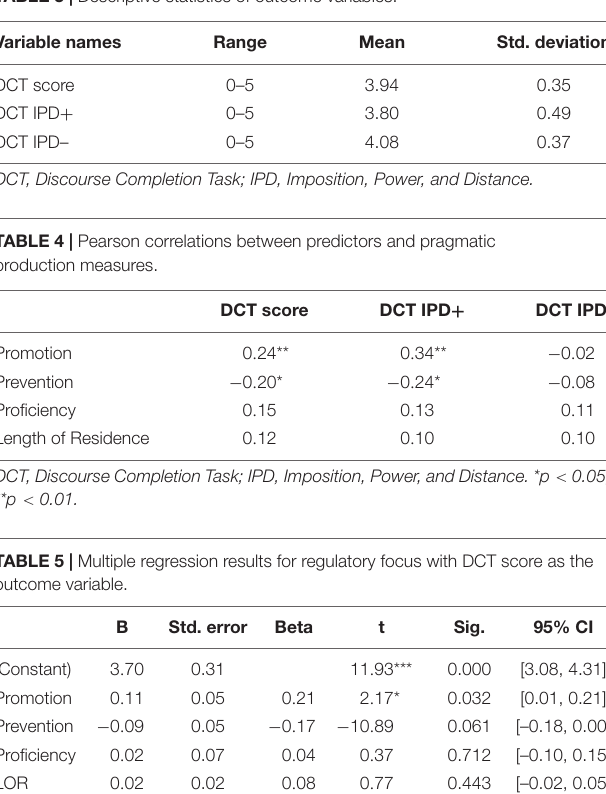
TABLE 3 | Descriptive statistics of outcome variables.